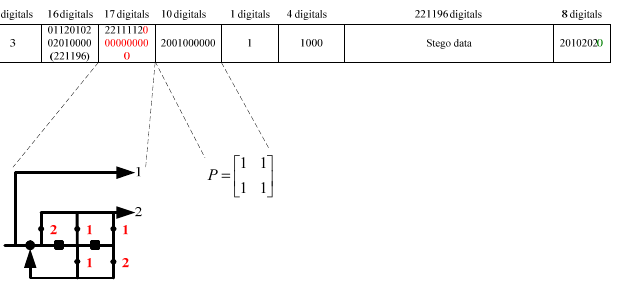
Figure 11. Packet form in the application field.